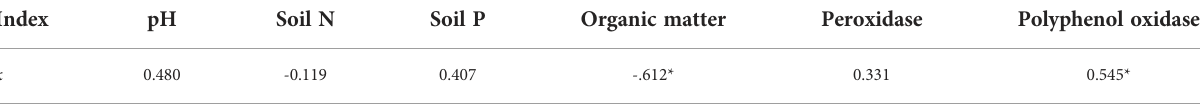
TABLE 5 Correlation between the decomposition constant ( k ) and soil